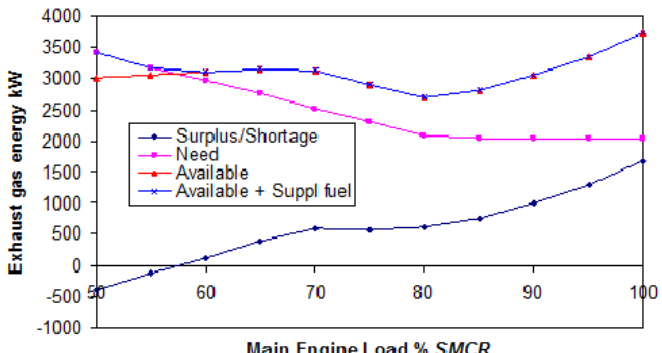
Figure 11. Exhaust gas energy and supplemental HFO energy at standard electrical power and heat for the R245fa fluid.